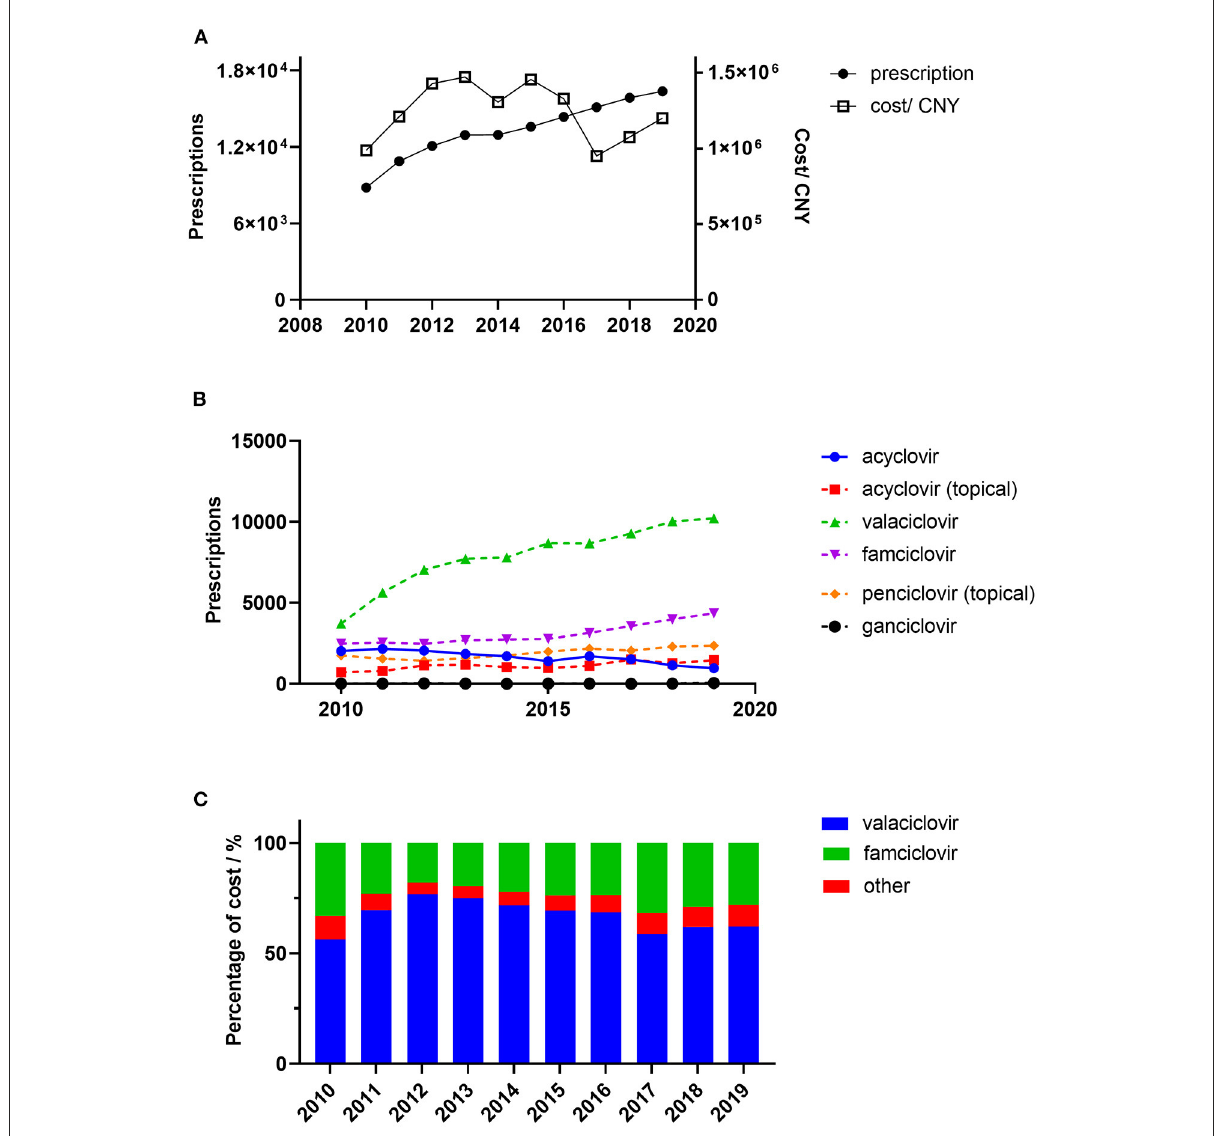
FIGURE1 Trends in the prescription of antiviral drugs for patients with herps zoster in six major areas of China. (A) Overall yearly prescriptions and cost; (B) Yearly prescription of individual drugs; (C) Antiviral cost percentages. Percentage of cost means the percentage of overall yearly cost of specific